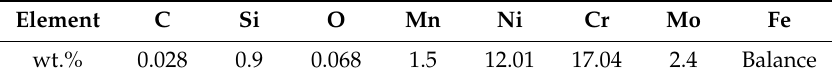
Table 1. Chemical composition of 316L SS powder.